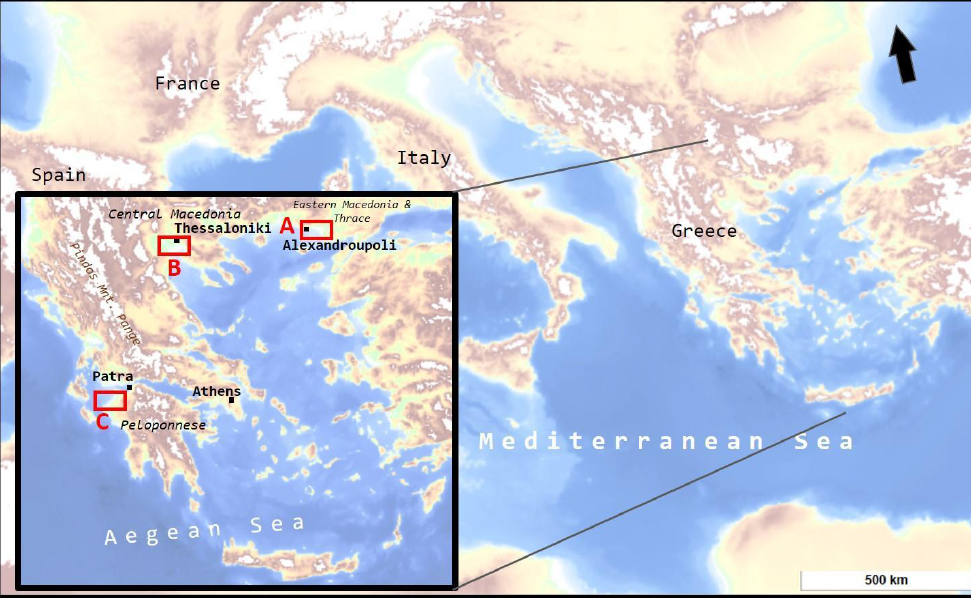
Figure 1. Location map of the three study areas. ( A ) Coastal urban area of the Alexandroupolis city—unique wetland area of the Evros Delta. ( B ) Coastal Zone of Thermaic Gulf; urban center of Thessaloniki city—Axios Delta. ( C ) Coastal Area of Killini—Araxos (Patras Gulf), northwestern Peloponnese.